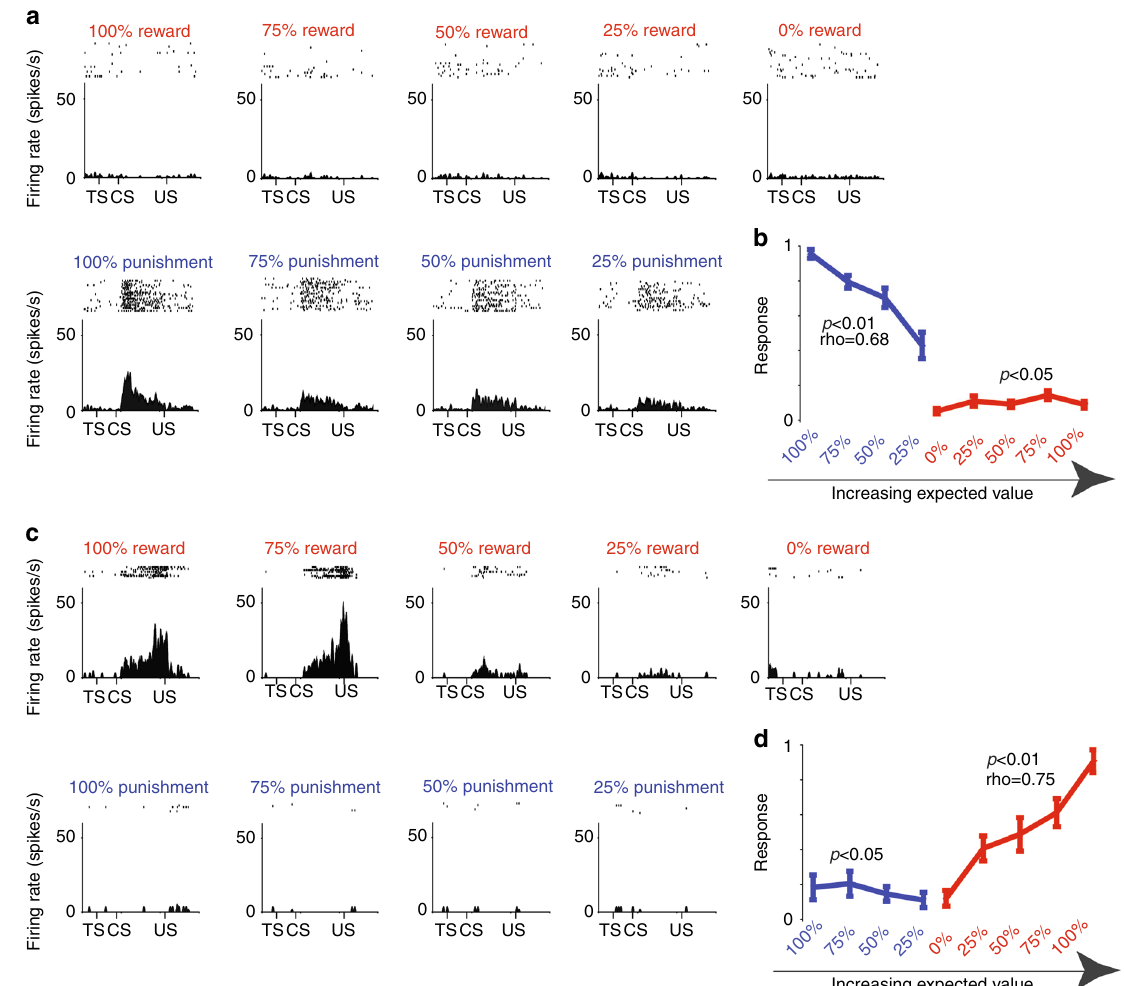
Fig. 3 Valence speci fi city in a single-block reward/punishment procedure. a The activity of a single punishment-sensitive ACC neuron shown separately for the nine CSs in the single block reward/punishment procedure. b The average activity of 16 punishment-enhanced neurons in ACC. c The activity of a single reward-sensitive ACC neuron shown separately for all nine CSs. d The average activity of nine reward-enhanced neurons in ACC. Spearman ’ s rank correlations of the average responses with reward and punishment probabilities are indicated in b and d . Error bars denote standard error. Classi fi cation of neurons as punishment-enhanced value coding neurons and reward-enhanced value coding neurons were the same as in Fig. 2 (Methods). Before averaging, single neurons ’ CS responses were normalized to the maximum CS response; from 0 to 1 (same as in Fig. 2c). Red — activity in reward